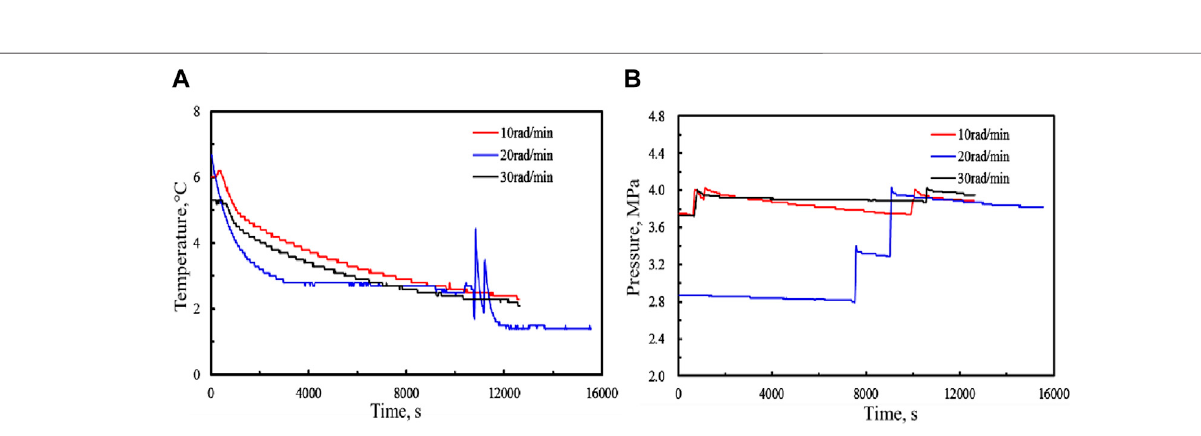
Frontiers in Energy Research |